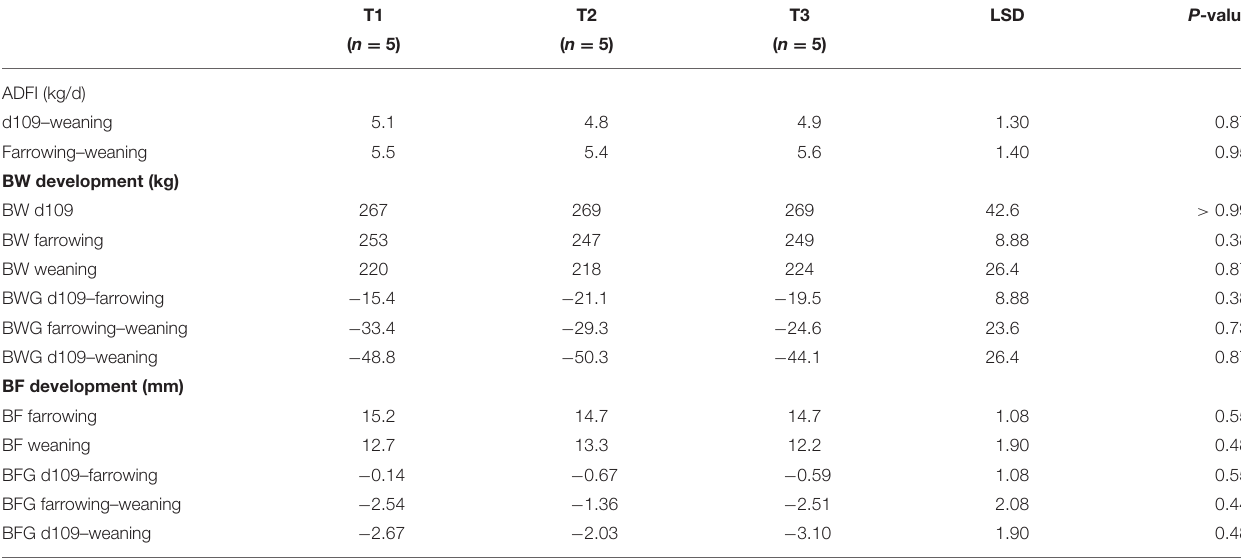
TABLE 3 | Effect of dietary treatments on average daily feed intake (ADFI), body weight (BW), BW gain (BWG), backfat (BF), and BF gain (BFG) a .